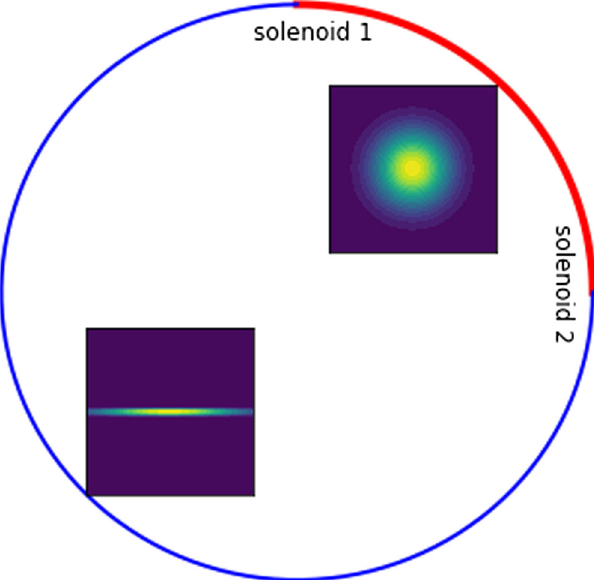
FIG. 14. Schematic diagram of a hybrid flat-round beam mode in a storage ring. A pair of solenoids are used to form a local closed section with a round beam (red arc), while maintaining a flat beam in the rest part of the ring (blue arc.)